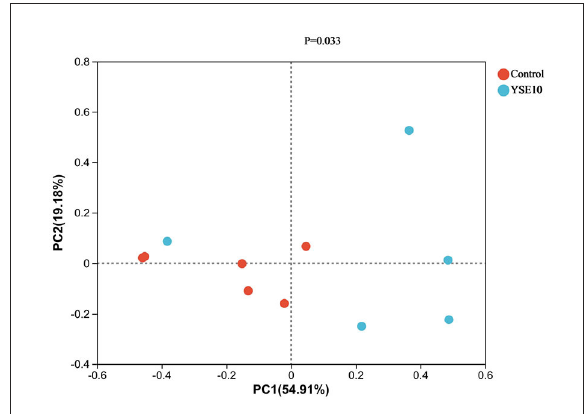
FIGURE4 Principal component analysis of operational taxonomic units. PC1, principal coordinate (1) PC2, principal coordinate; (2) Control, 0.9% NaCl solution; YSE10, 10 mg/mL YSE.